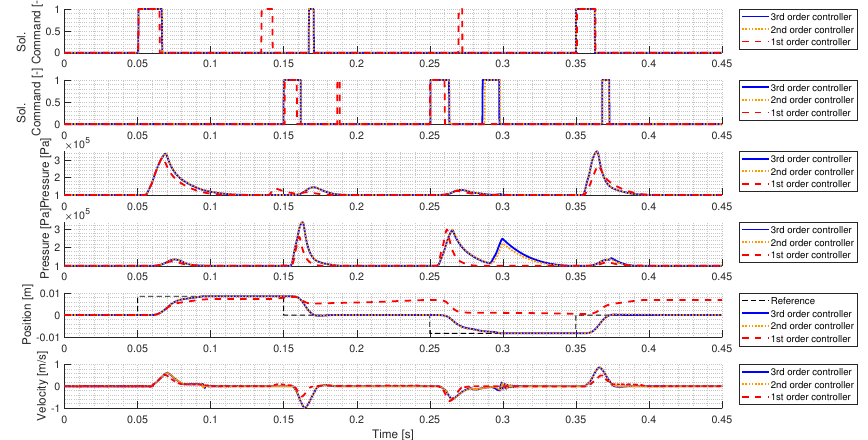
Figure 8. Controller order